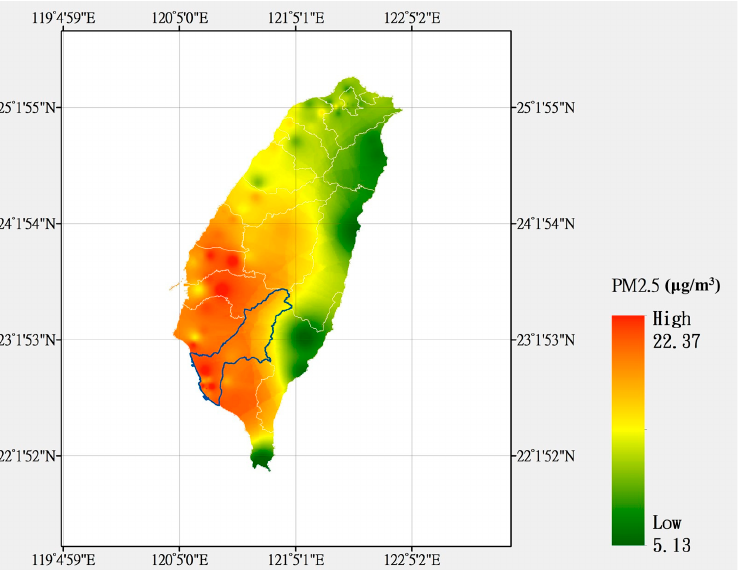
Figure 1. Distribution of annual average PM2.5 concentration from 2021 in Kaohsiung, Taiwan.